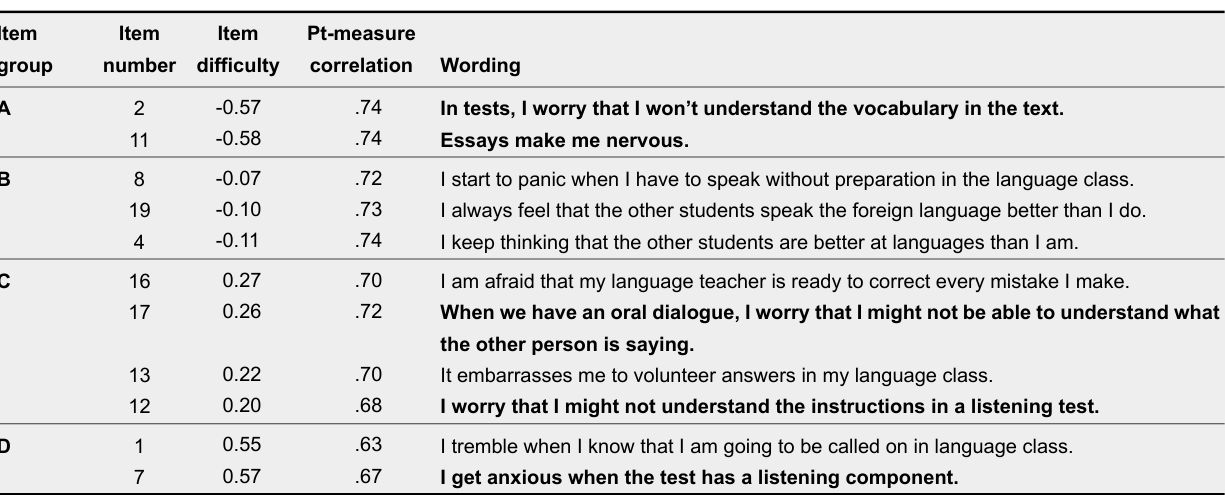
Groups of Statistically Similar